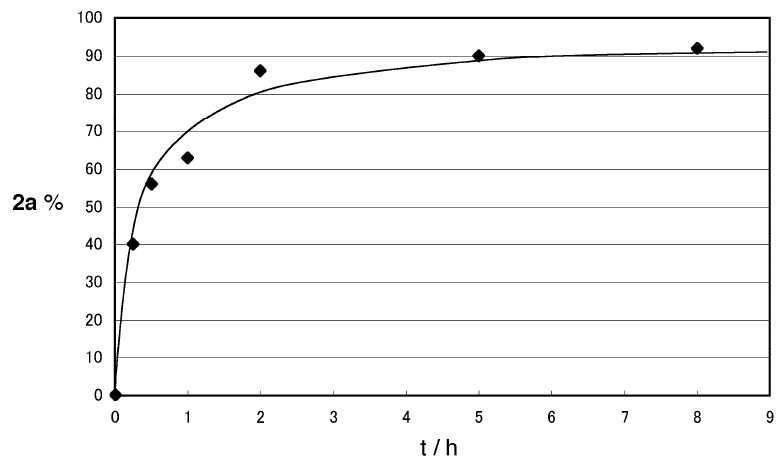
Figure 5. Plots of the yield of 2a vs. irradiation time.